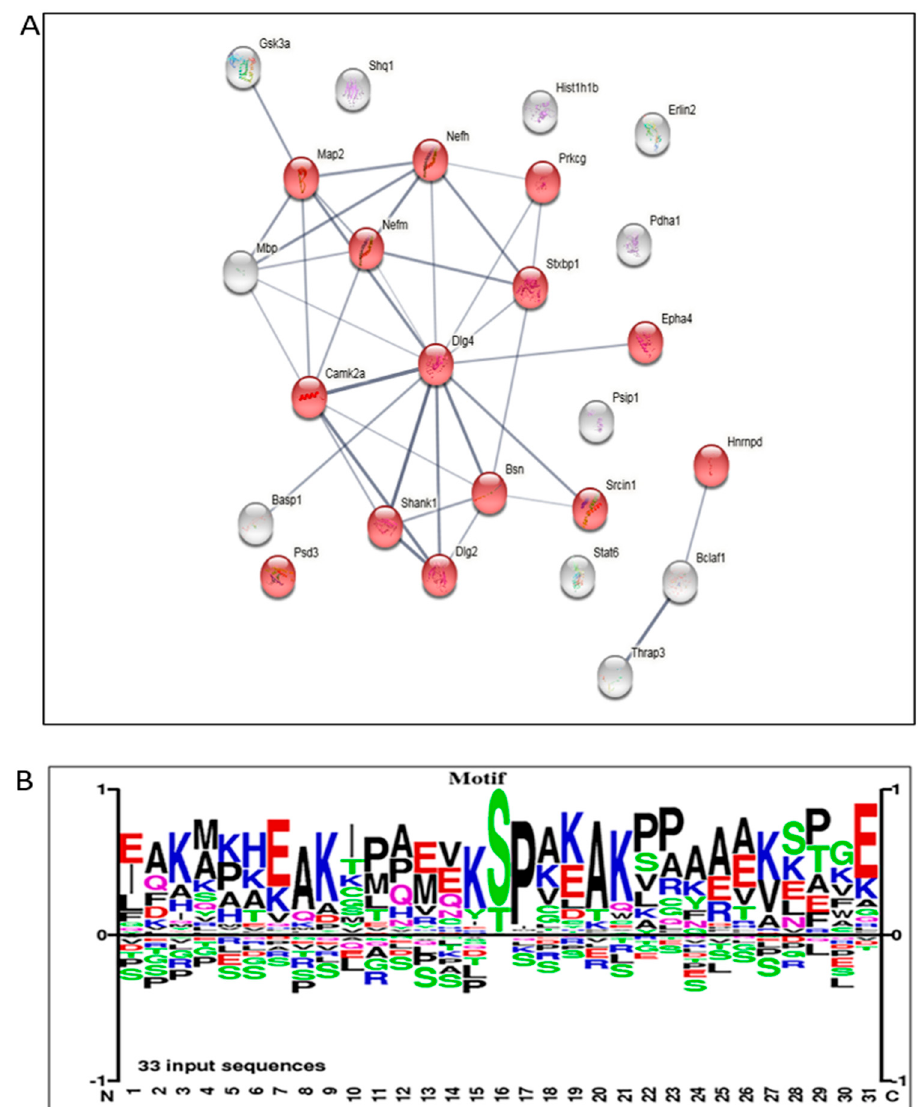
Figure 7. Proteomics analysis of the hippocampus: PTM-phosphorylation analysis. ( A ) STRING analysis of close clustering of synapse related proteins (in red) (full names of proteins are presented in the Supplemental hippocampus-phospho-proteomics-excel). ( B ) Identification of the amino-acid motifs of the differential phospho-peptides between the AD and treated AD groups in the brain samples.